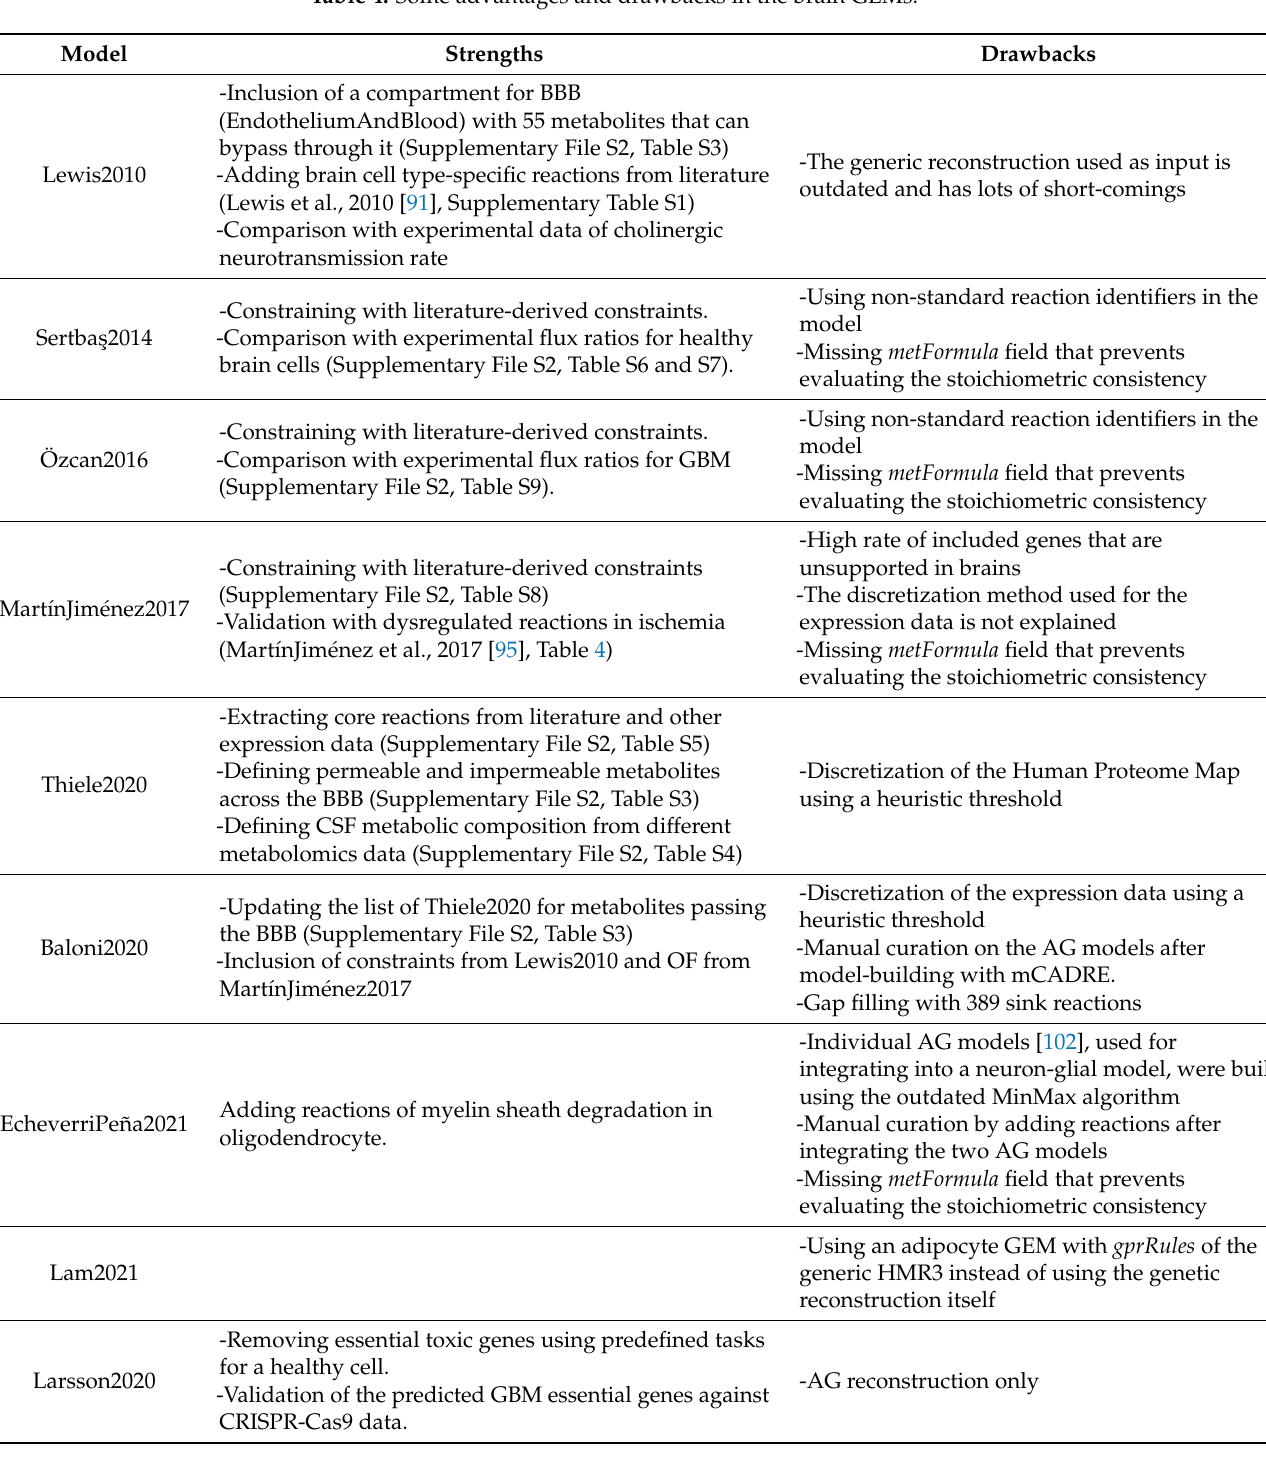
Table 4. Some advantages and drawbacks in the brain